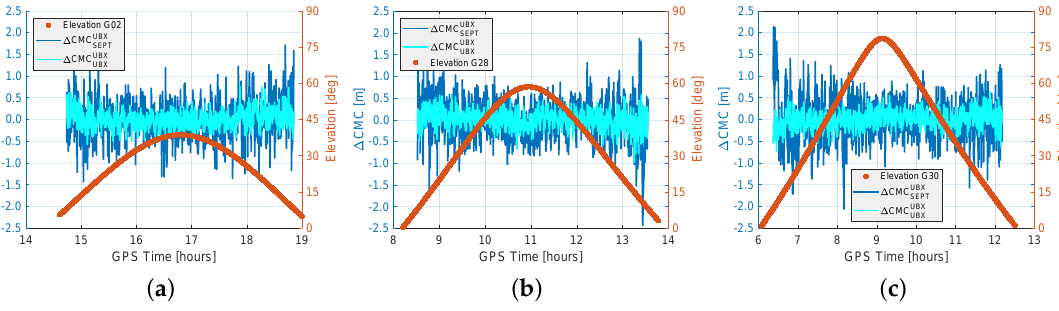
Figure 9. Differential CMC ( ∆ CMC) residuals for both, consumer grade and geodetic receiver combinations for satellites of different elevation on DOY067, 2018; ( a ) low elevation, ( b ) mean elevation, ( c ) high elevation. Initial offsets are eliminated for each pair of